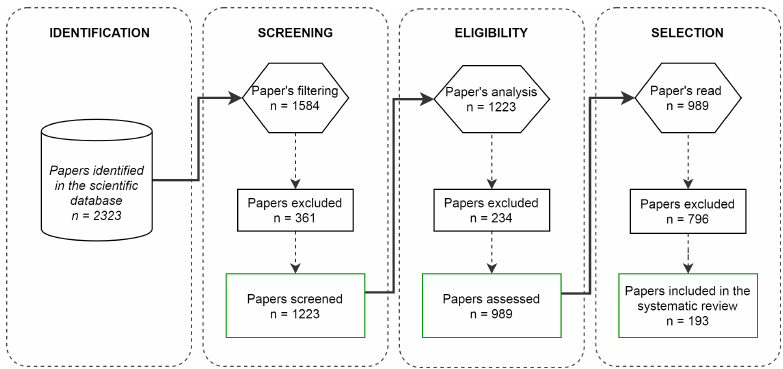
Figure 1. Schematic process to select the papers from 2015 to 2020 presented in this systematic